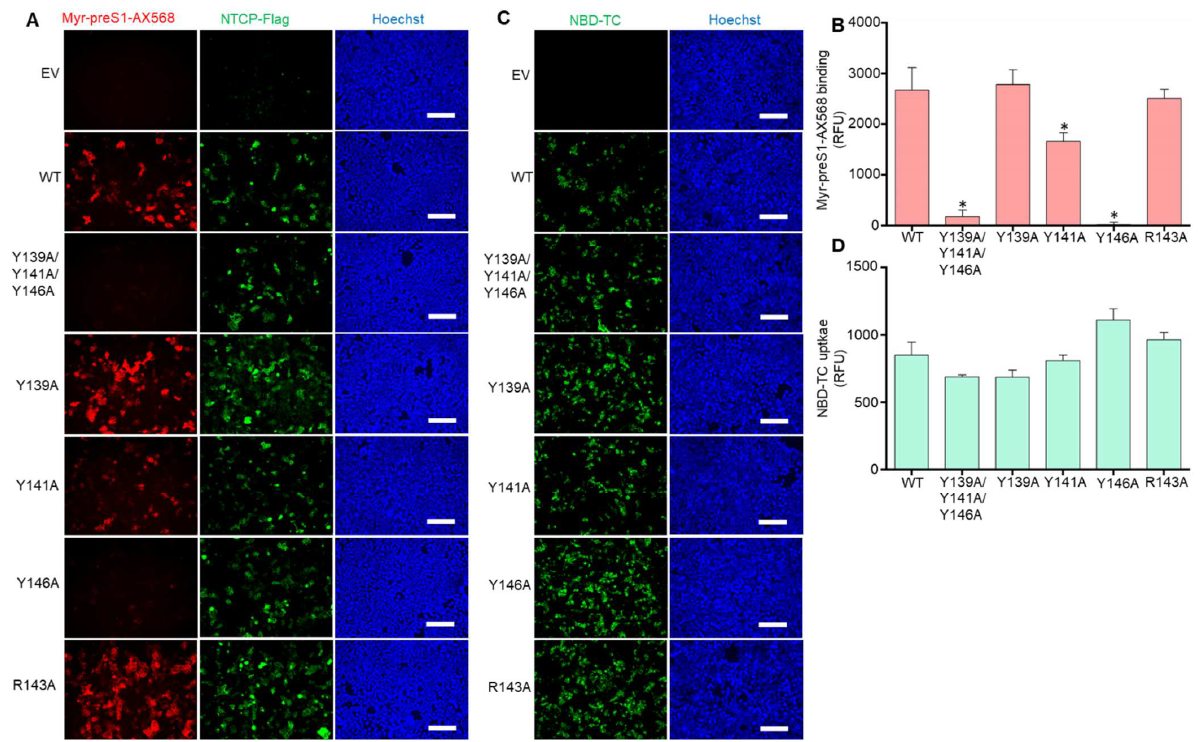
Figure 2. Bile acid transport function and myr-preS1 receptor function of the NTCP mutants. ( A ) Binding of the fluorescently labeled viral myr-preS1-AX568 peptide (red, 50 nM incubated for 20 min at 37 °C) was analyzed using florescence microcopy in HEK293 cells expressing the indicated NTCP mutant constructs. Successful NTCP transfection was confirmed using rabbit anti-FLAG primary and Alexa Fluor 488-labeled goat anti-rabbit secondary antibodies (green). Nuclei were stained by Hoechst 33342 (blue). Scale bars: 130 µm. Representative fluorescence images are shown. ( B ) For quantification of myr-preS1-AX568 peptide binding to NTCP, fluorescence images were captured on Leica DMI6000 B fluorescent microscope and fluorescence signals were quantified with the LAS-X imaging software (Leica) by determining cell-based fluorescence in defined regions of interest (ROI). Data are presented as mean background-subtracted relative fluorescence units (RFU). ( C ) Bile acid transport activity of HEK293 cells overexpressing wt NTCP or the indicated mutant NTCP proteins was analyzed using 5 µM NBD-TC incubated as NTCP substrate for 30 min at 37 °C (green). Nuclei were stained by Hoechst 33342 (blue). Scale bars: 130 µm. ( D ) For quantification of NBD-TC transport into NTCP-expressing HEK293 cells, fluorescence images were quantified with the LAS-X imaging software (Leica) by determining cell-based fluorescence in defined ROI. Data are presented as mean background-subtracted relative fluorescence units (RFU). Data represent means ± SD for three independent experiments. EV, empty vector. * Significantly lower compared to wt NTCP with p < 0.001 according to one-way ANOVA with Dunnett’s multiple comparison post- hoc test.